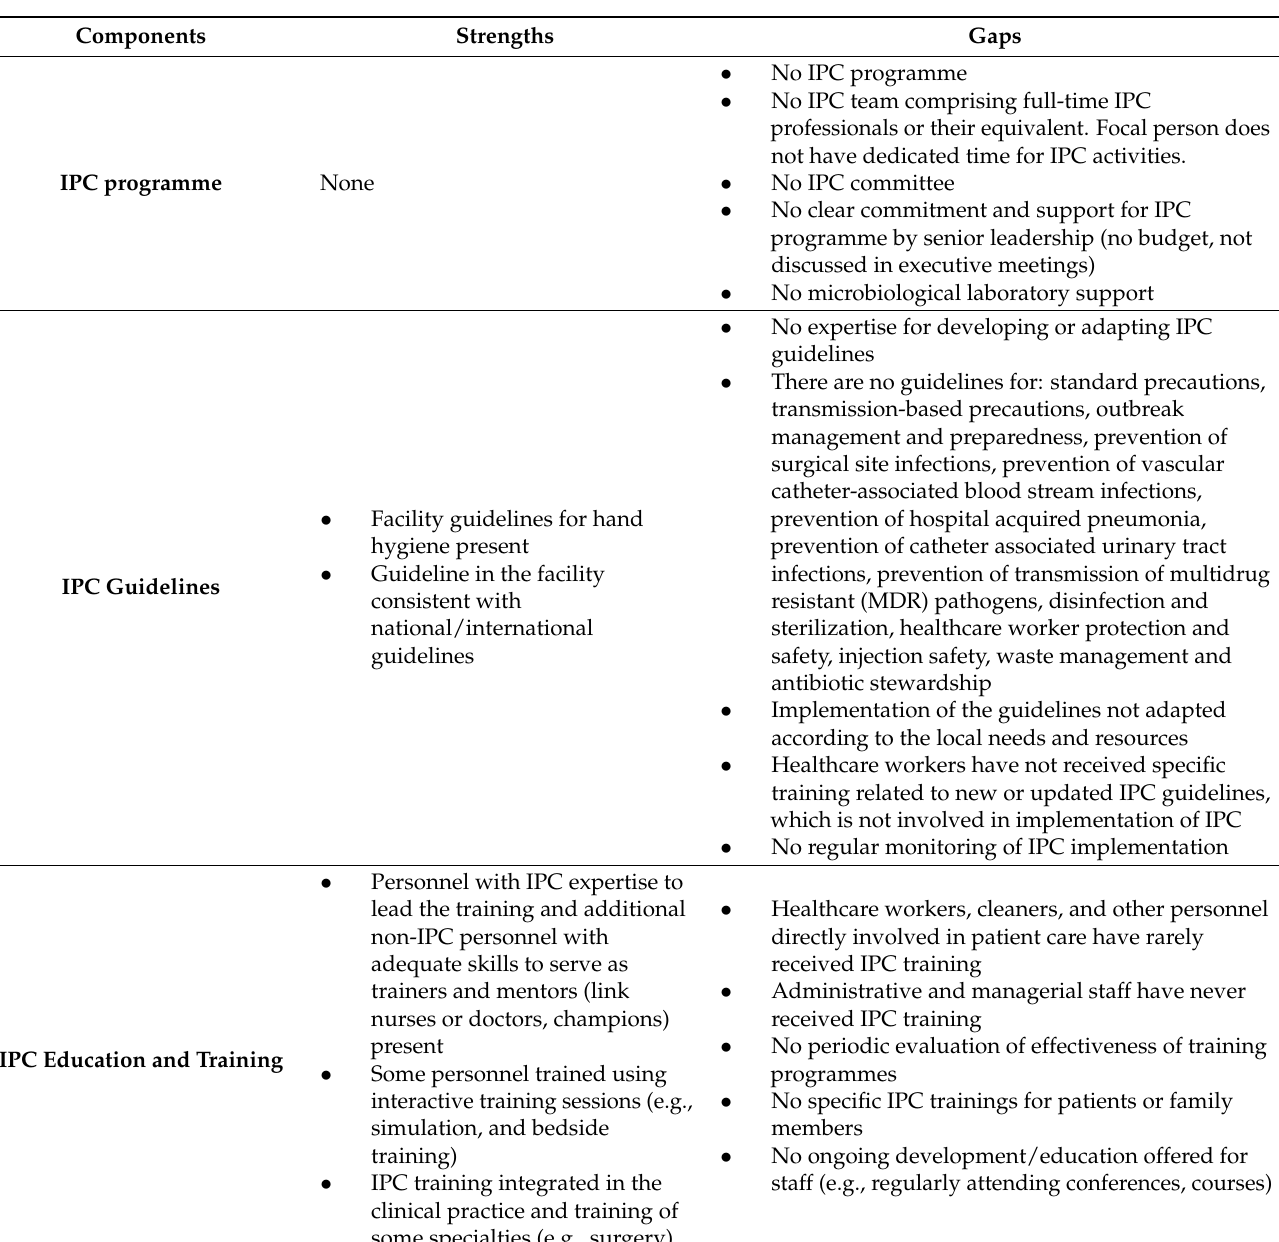
Table 3. Strengths and gaps in IPC (Infection prevention and control) programme, guidelines, IPC education and training identified during a baseline IPC assessment at Lira University Hospital, Uganda, in November